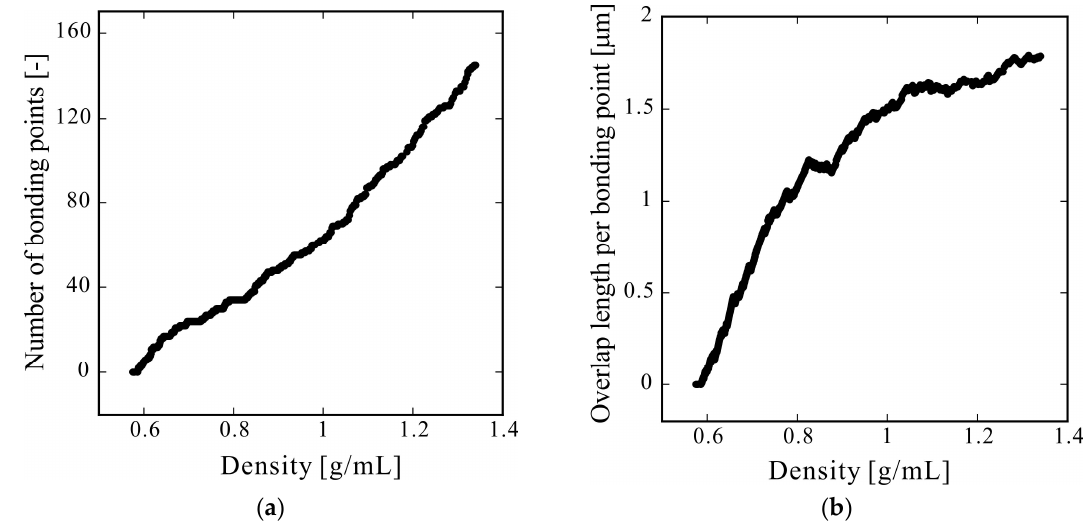
Figure 6. Plots of ( a ) the number of overlap points and ( b ) the average overlap length as functions of